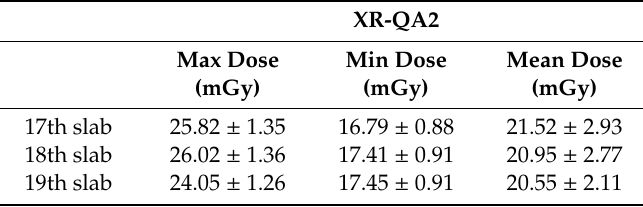
Table 3. Maximum, minimum and average dose value measured with XR-QA2 films for the 17th, 18th and 19th slab.